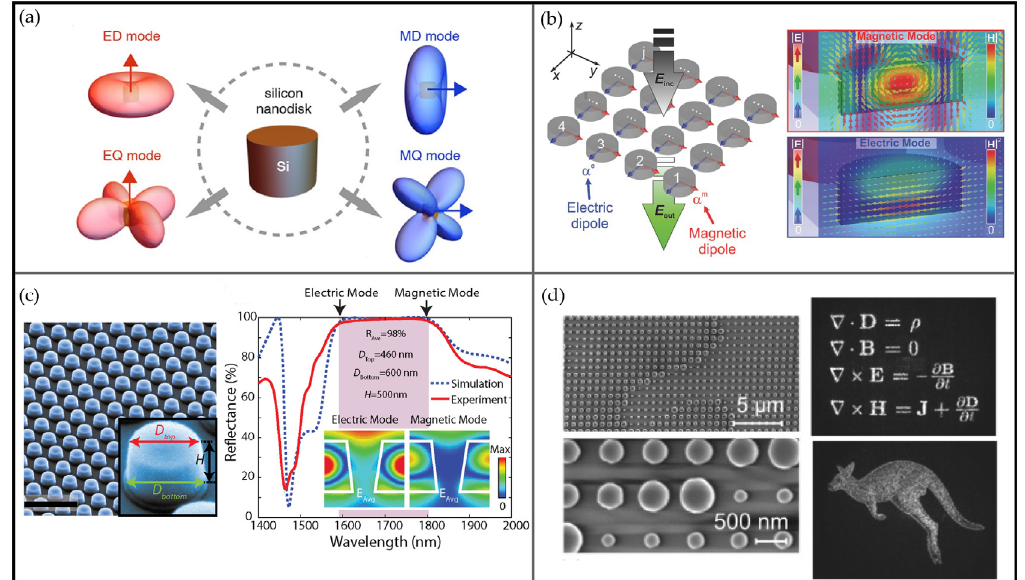
Figure 1. ( a ) The radiation spectra of fundamental Mie resonances of Si nanodisks. Reproduced with